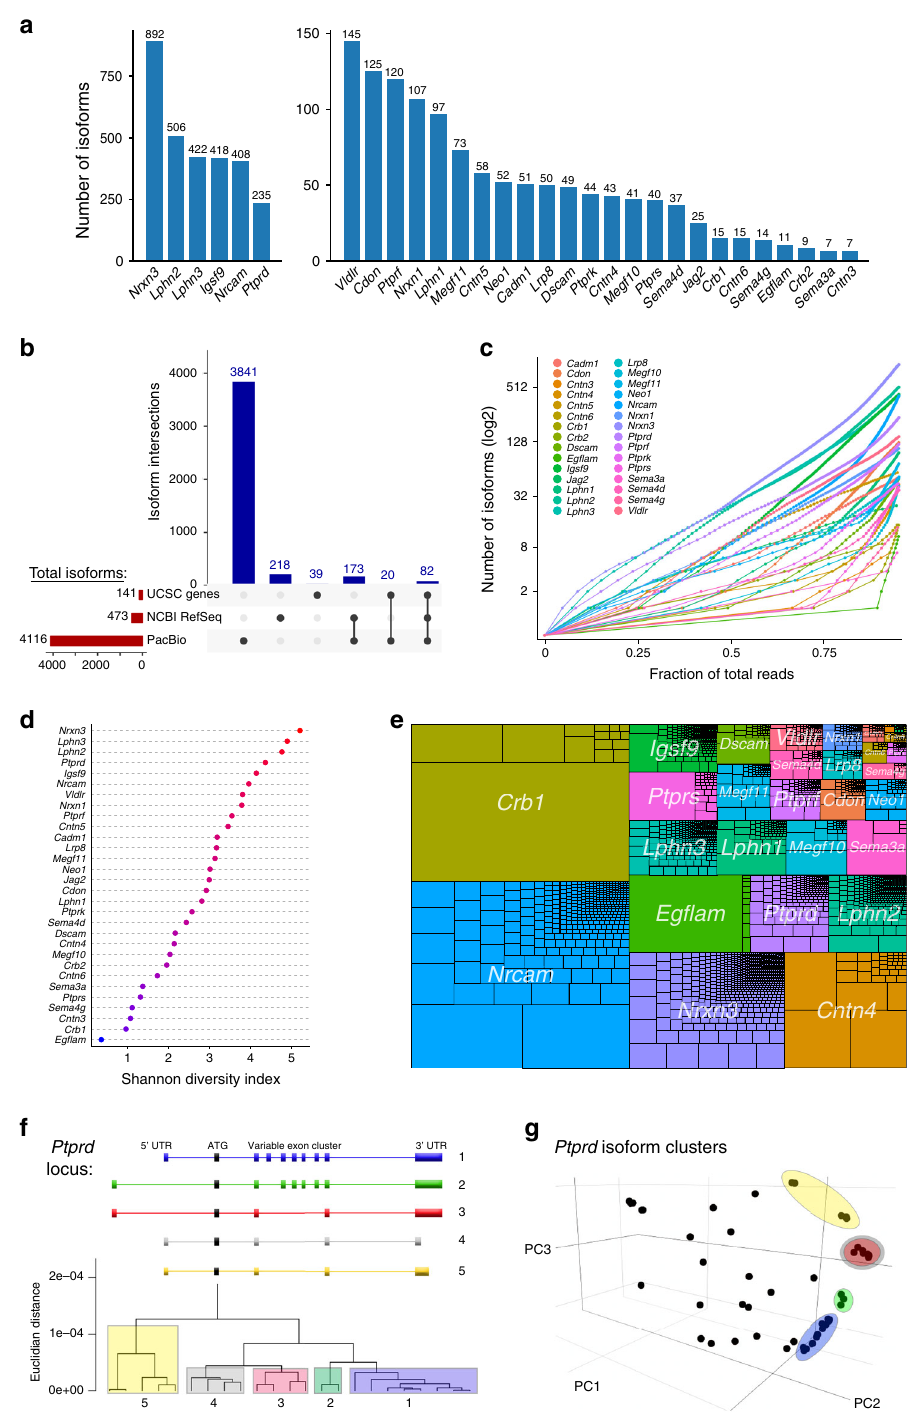
junction coverage for 71% of lrCaptureSeq isoforms ( n = 2925). The uncon fi rmed junctions were likely absent from the RNA-seq data due to low expression levels, since the isoforms that did not show complete coverage were signi fi cantly less abundant (Supplementary Fig. 2b). Consistent with this interpretation, uncon fi rmed junctions could be detected by sequencing of RT- PCR products, suggesting that they were simply below RNA-seq detection threshold ( n = 9/12 absent RNA-seq junctions in Megf11 gene were detected by RT-PCR). Together, these analyses strongly support the validity of the full-length sequences within the lrCaptureSeq isoform